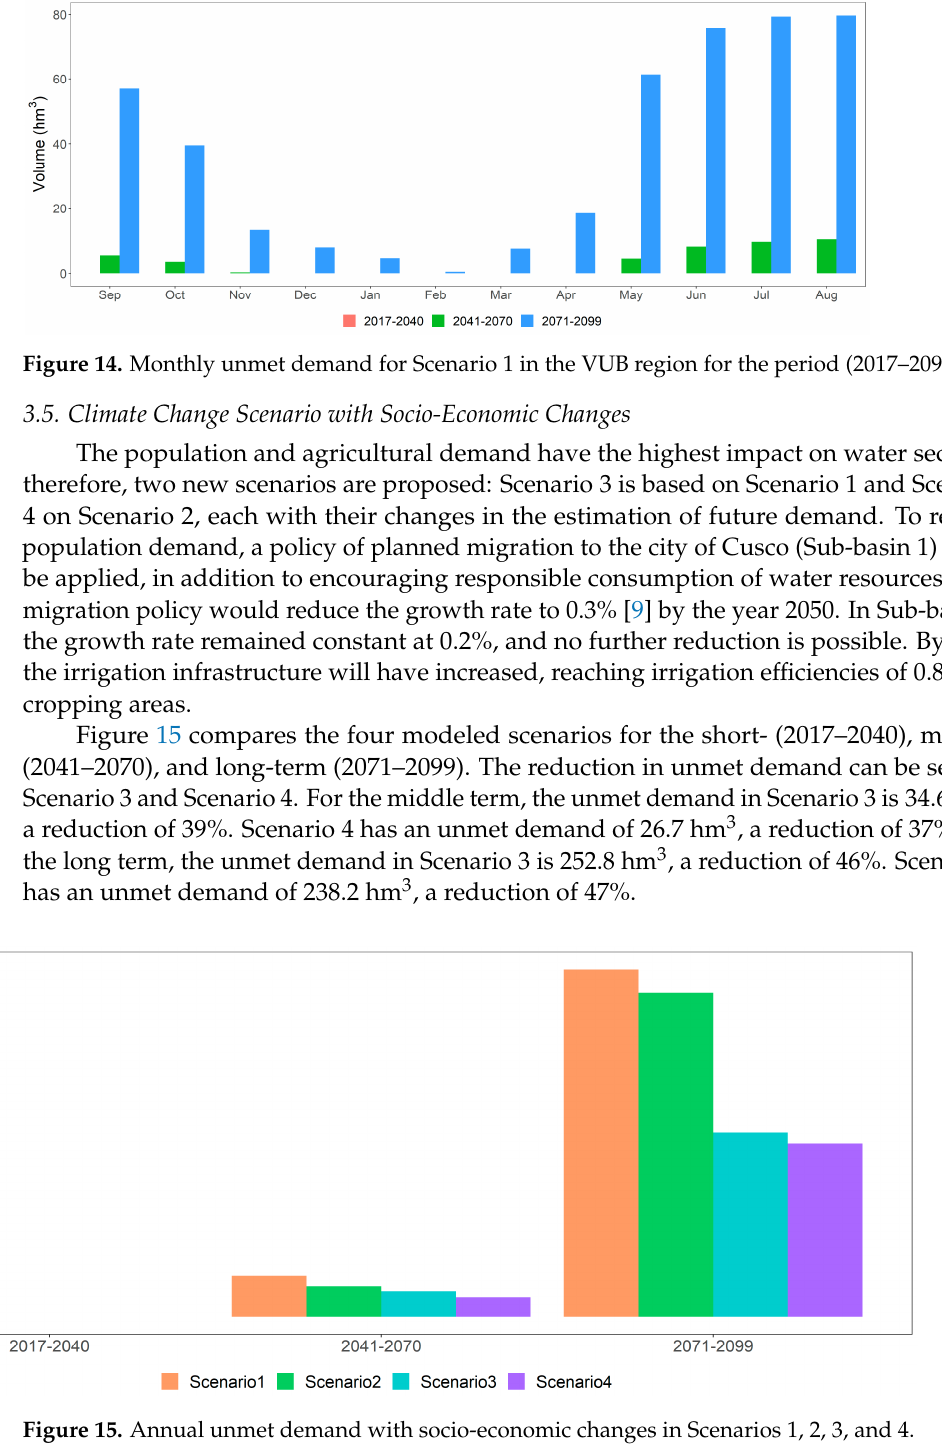
Figure 13. Annual unmet demand for Scenarios 1 and 2 for the period 1981–2099.